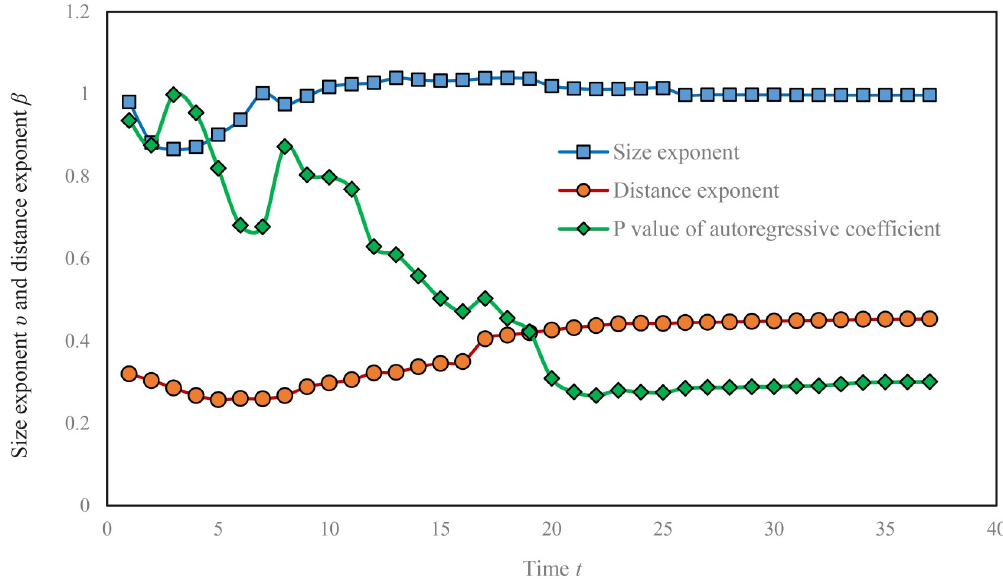
Fig 2. The variation of gravity scaling exponent of COVID-19 diffusion in Hubei Province. (1) The first point of the sequence of horizontal axis represents January 28. Previous data were not complete enough to be used. (2) The size exponent and distance exponent are estimated based on Eq (7), and the probability value of autoregressive coefficient is given based on Eq (8).